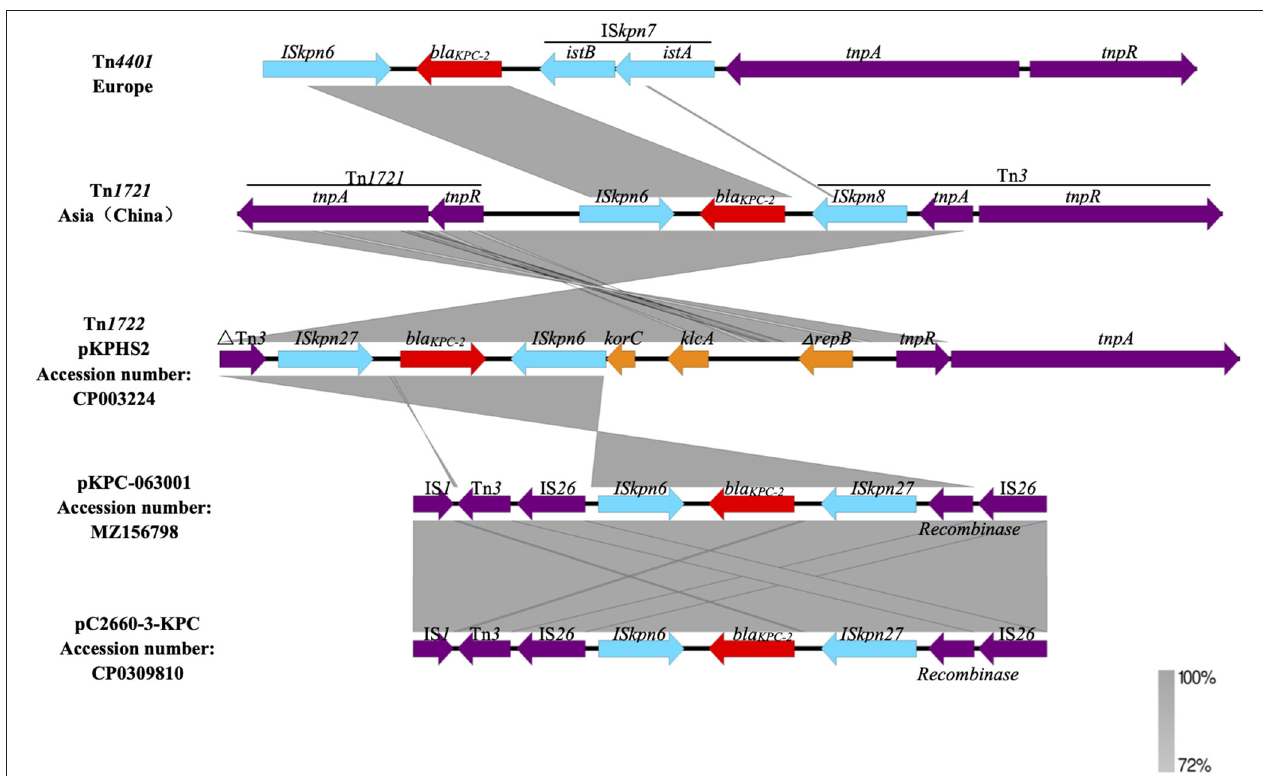
FIGURE 5 | Comparison of the surrounding environment of bla KPC − 2